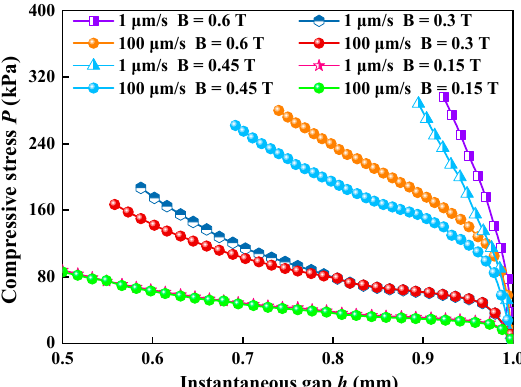
Figure 4. Comparison of the value of compressive stresses under two different compressive speeds (5 and 10 μ m/s) and different magnetic flux densities (0.15 T, 0.3 T, 0.45 T, and 0.63 T). According to the experimental values in Figure 3, the calculated values of logarithm for P and h at B = 0.15 T, B = 0.3 T, B = 0.45 T, and B = 0.6 T are displayed in Figure 5a–d, respectively. The curves at different v can be fitted by linear functions. When B = 0.15 T, the curves applied at different v overlap over most of the ranges. In the plastic flow pro ‐ cess, a linear line with a slope of − 2 is well ‐ used to capture ln P with ln h at different v . The fitted curve is also shown in Figure 5a. Based on the continuum media theory, the power law relationship between F / P and 1/ h with the index n = 1 is predicted [15]. Therefore, the value of the theoretical slope ( n + 1) should be 2. It is an obviously weak gap distance dependence under this low field of 0.15 T. Therefore, we may conclude that n should be about 1 at this low B in Equation (4). Figure 5a indicates that the principle of the continu ‐ ous media theory may well depict the squeezing behavior of MR fluid at this low B .